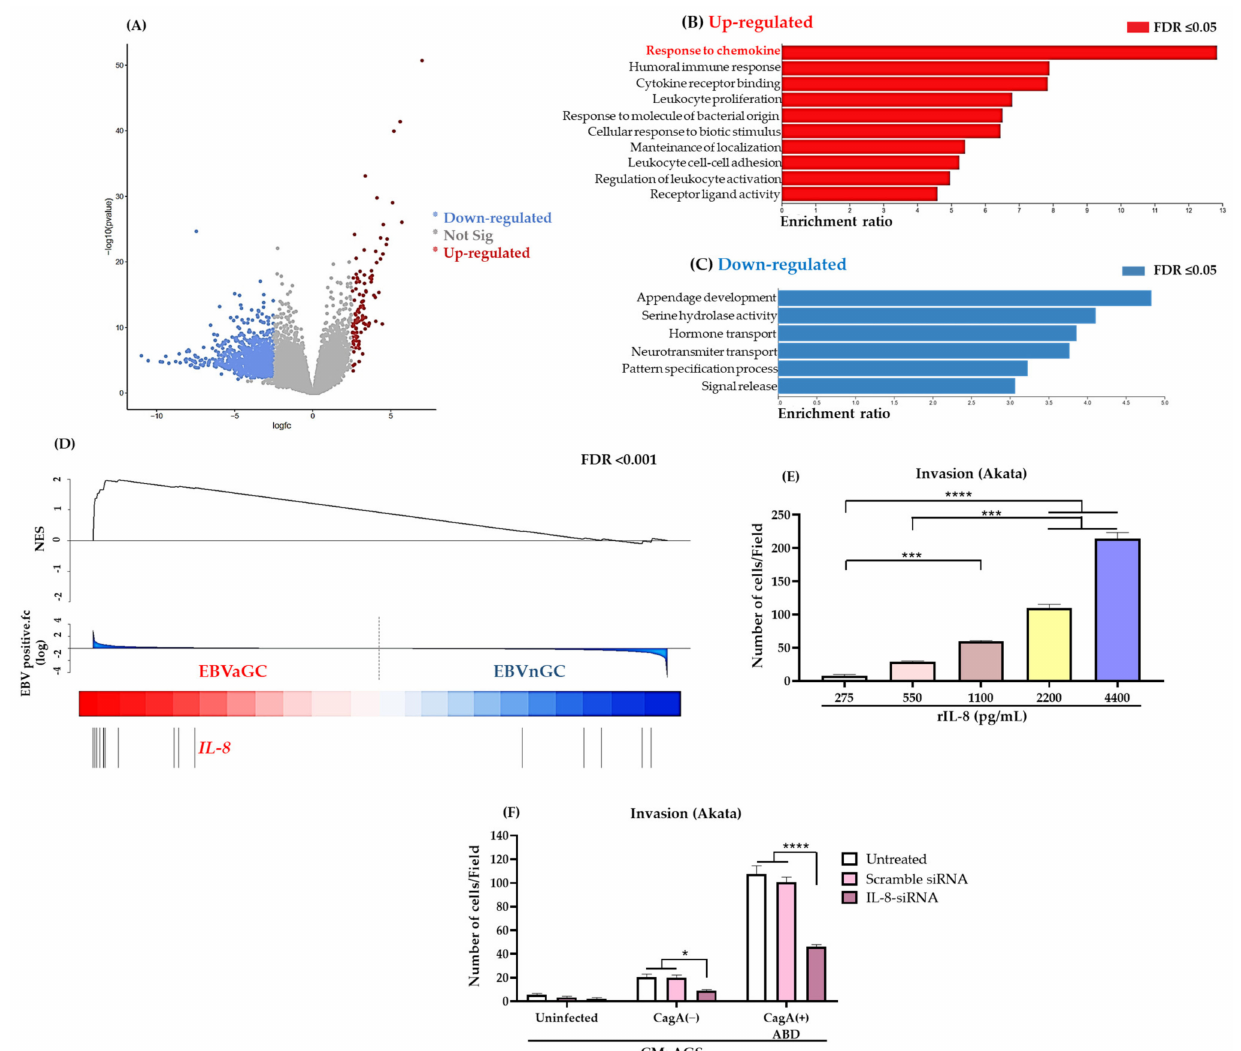
Figure 4. IL-8 is an important chemoattractor of EBV-infected B lymphocytes. ( A ) Volcano plot shows differentially expressed genes (DEG) between samples EBVaGC ( n = 22) versus EBVnGC ( n = 218). Red dots indicate up-regulated genes and blue dots indicate down-regulated genes, grey dots are genes that are not significantly different (Not sig). ( B , C ) Gene Ontology (GO) analysis of DEG in the comparison of EBVaGC vs. EBVnGC. Genes with a fold change up ( B ) or down ( C ) of at least 2.5 and False Discovery Rate (FDR) with a p -value ≤ 0.05 were included in this analysis. ( D ) Normalized Enrichment Score (NES) of a coined gene signature of chemokine and chemokine receptors (see Supplementary Table S1) to compare EBVaGC versus EBVnGC samples, IL-8 (in red) appears as one of the chemokines with a top score. ( E ) Invasion assays of Akata cells chemoattracted to increasing concentrations of rIL-8. A non-parametric Kruskal–Wallis and Dunn’s post hoc tests were used for the statistical analyses. ( F ) Invasion assays of Akata cells chemoattracted to conditioned media from AGS cells knocked down in IL-8 expression and then infected with H. pylori strains. As controls, cells were left untreated or transfected with a scramble siRNA. ( E , F ) Graphs represent the mean ± SEM of the number of invading cells counted from 5 random microscope fields of three independent experiments. A 2-way ANOVA for multiple comparison and Dunnett’s post hoc test were used to identify statistical differences. * p < 0.05, *** p < 0.001 and **** p < 0.0001. We observed IL-8 among the chemokines with the highest score. IL-8 is a chemokine that triggers the migration and activation of neutrophils during the H. pylori chronic infection of the gastric mucosa [13–15], and is a chemokine important in the development